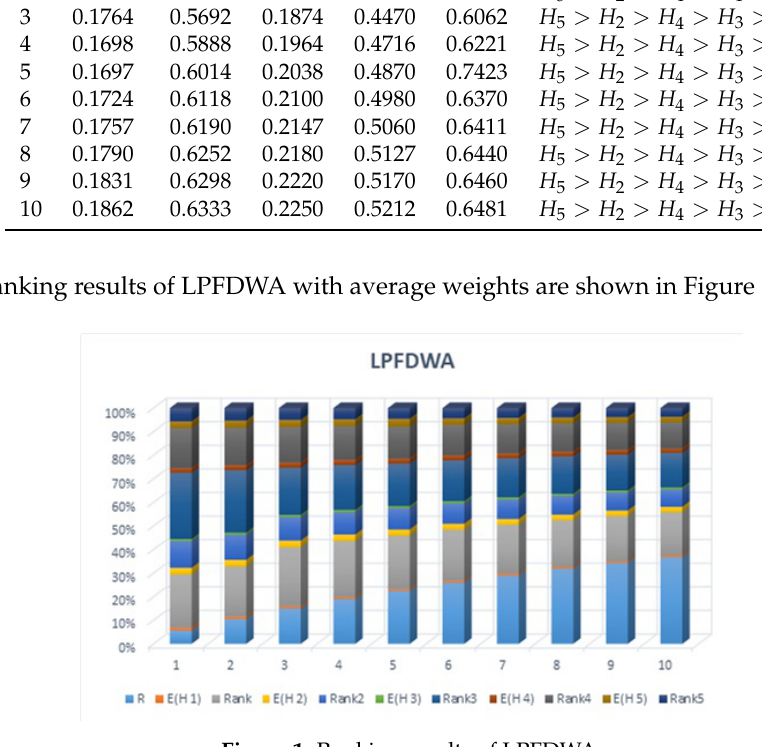
Figure 1. Ranking results of